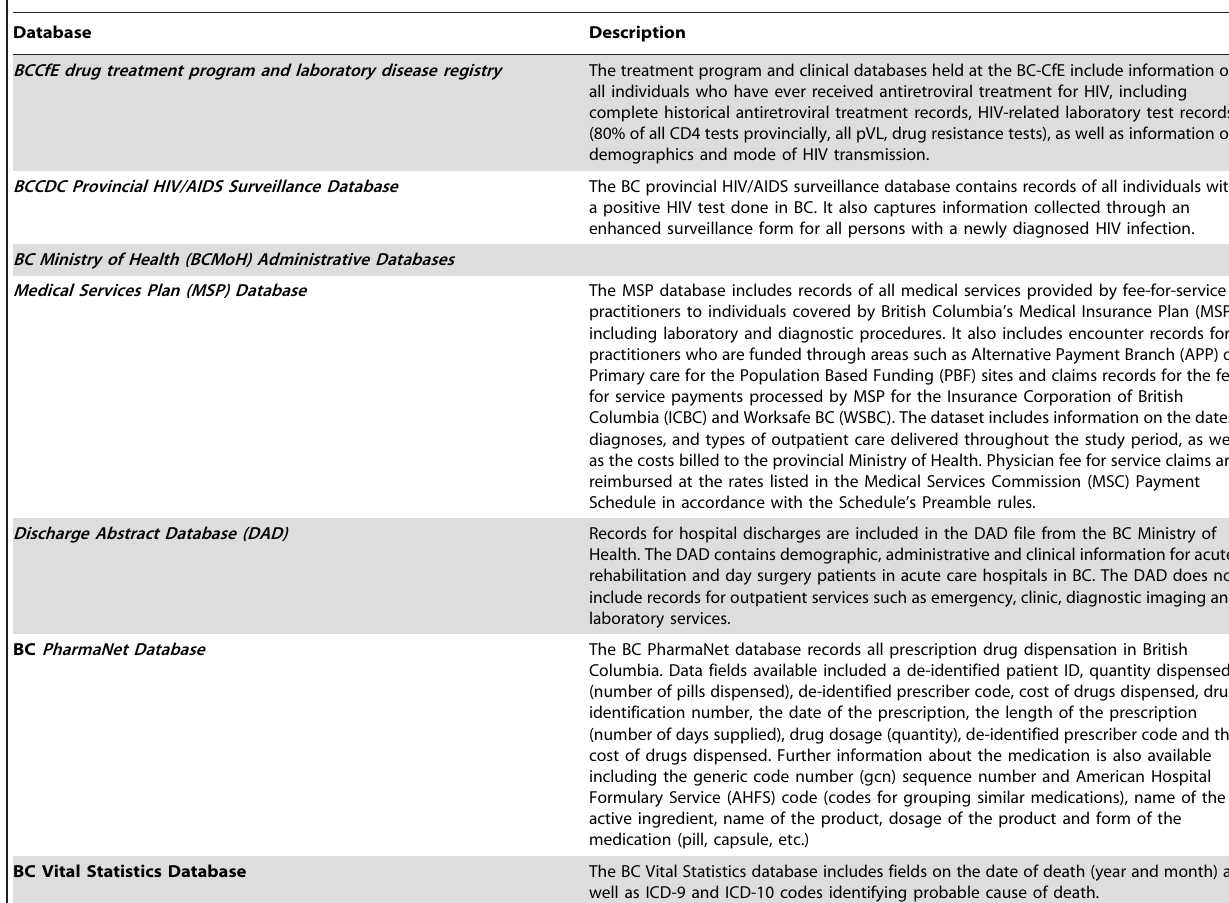
Table 1. Descriptions of databases used for cohort